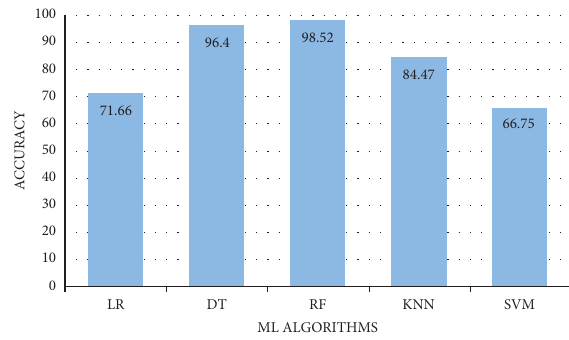
Figure 8: Comparison of